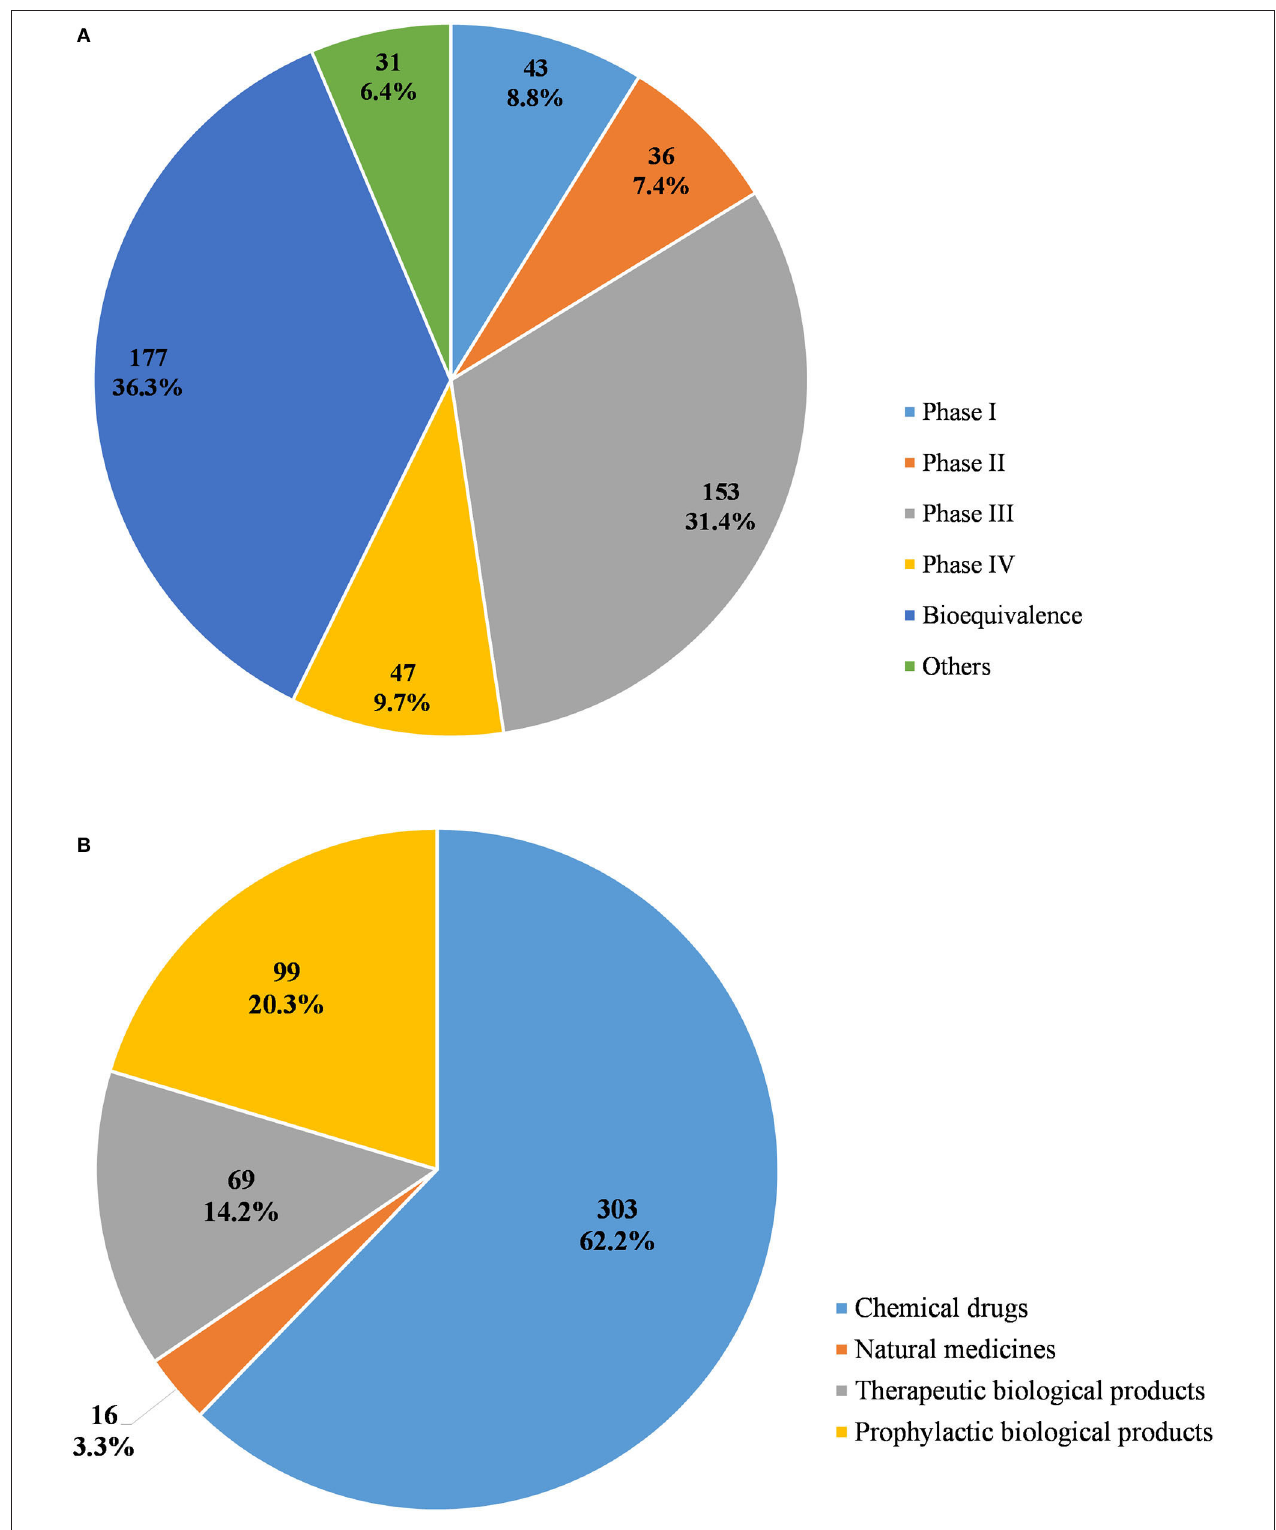
FIGURE 2 | Distribution of pediatric clinical trials by classification of study phases (A) and drug type (B) .